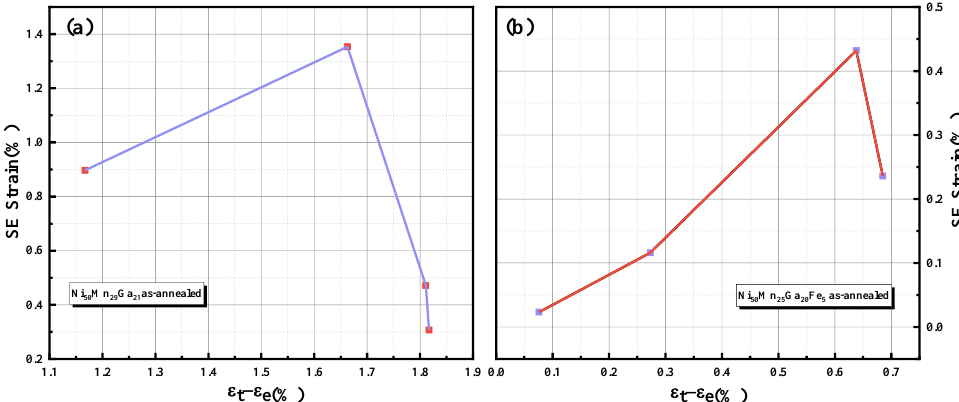
Figure 9. ( a )SE strain-applied strain curves of Ni 50 Mn 29 Ga 21 microwire, ( b )SE strain-applied strain Figure 9. ( a ) SE strain-applied strain curves of Ni 50 Mn 29 Ga 21 microwire, ( b ) SE strain-applied strain curves of Ni 50 Mn 25 Ga 20 Fe 5 microwire. curves of Ni 50 Mn 25 Ga 20 Fe 5